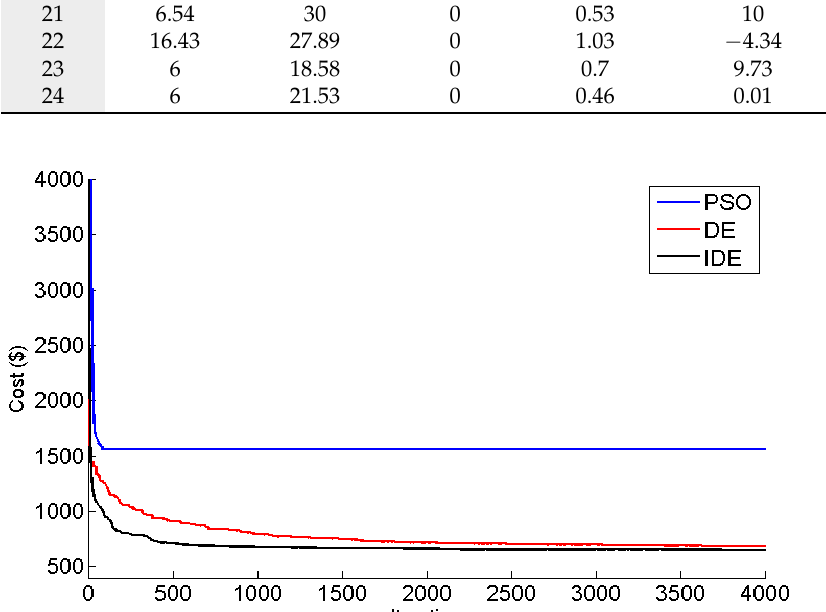
Figure 5. Convergence diagrams of gas emission in different methods considering the limitations of power exchange with upstream network. Table 9. Power distribution for reducing costs and considering the limitations of the upstream network exchange. Time